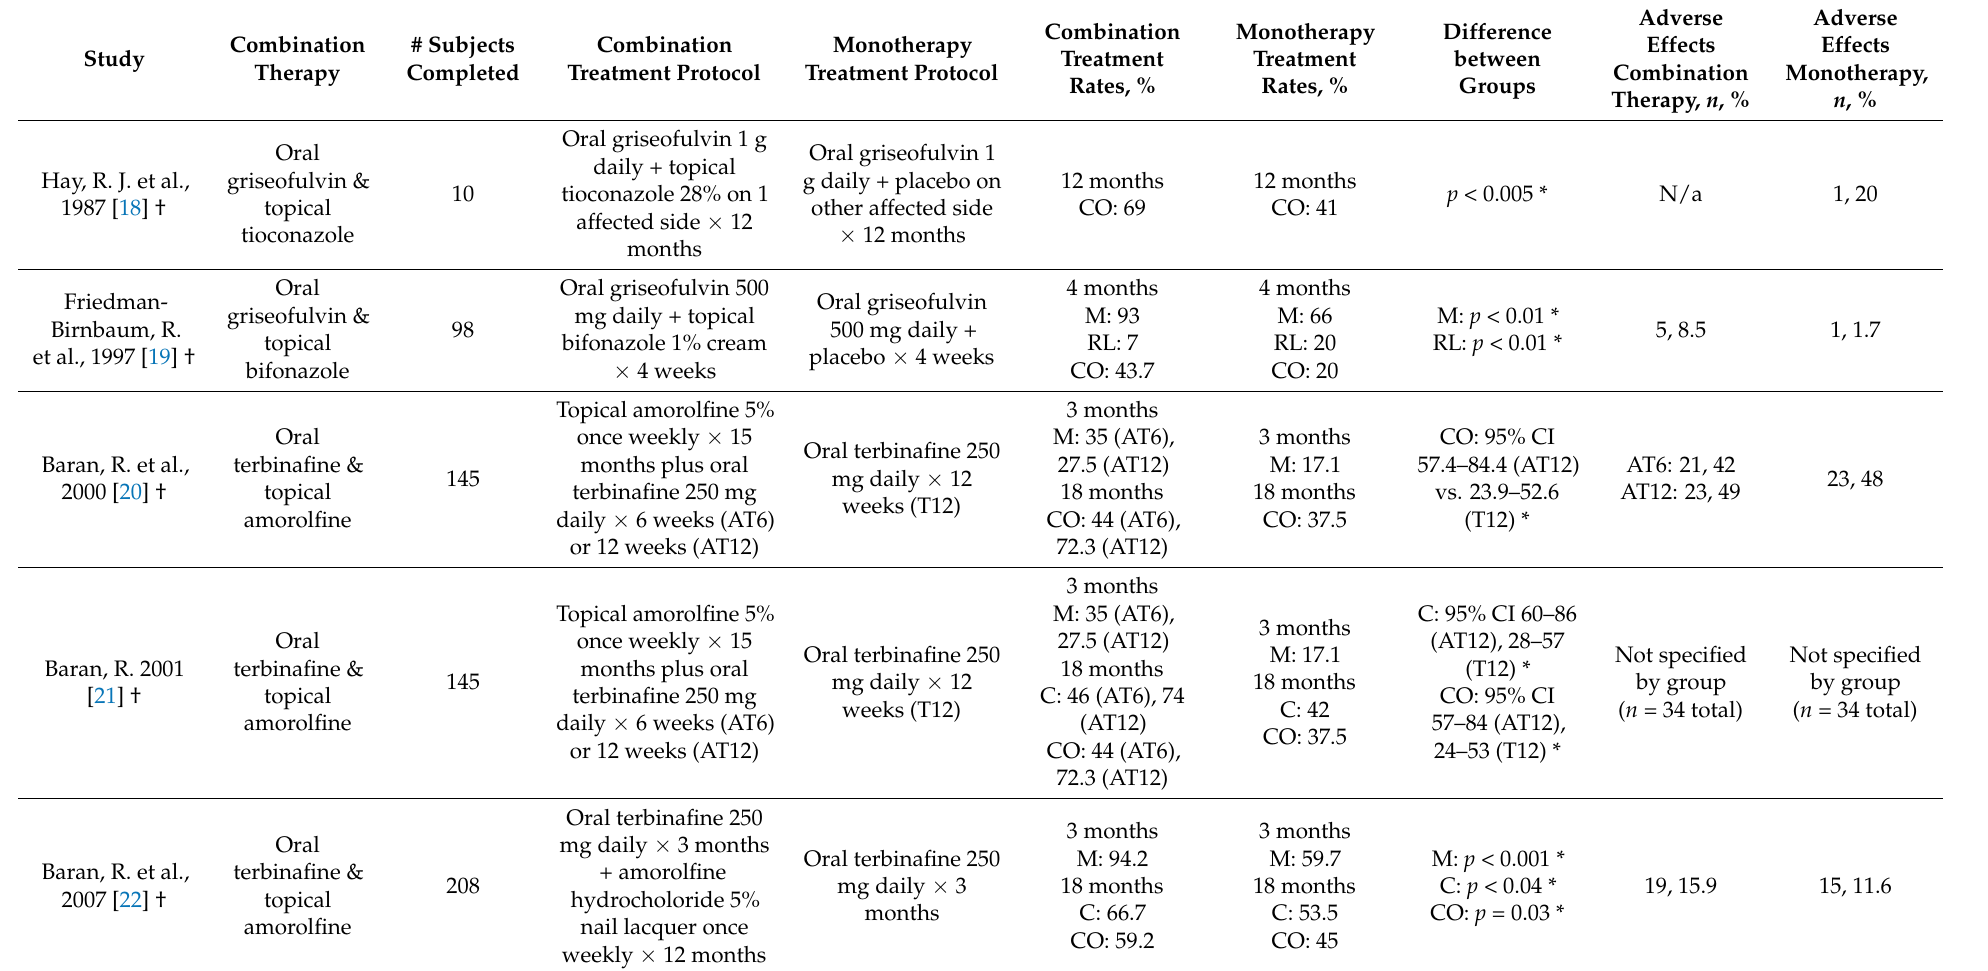
Table 1. Treatment protocols and outcomes for studies investigating medication-only based combination therapies for onychomycosis